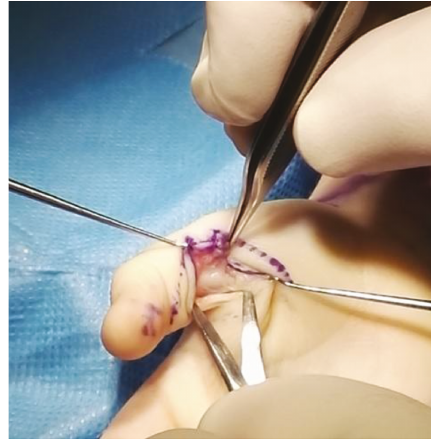
Figure 2: Node of Notta visible during A1 pulley